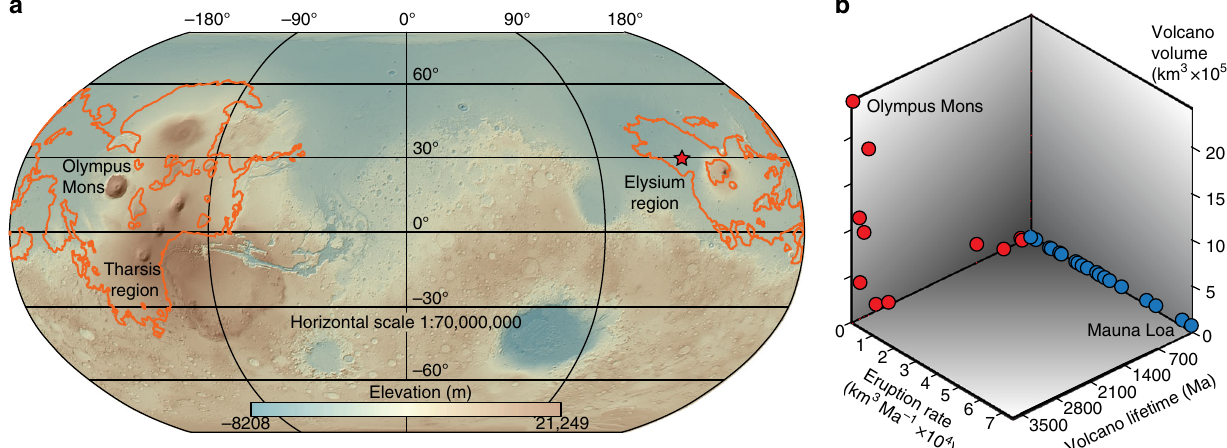
Fig. 1 Distribution and size of Martian volcanoes. a Amazonian volcanic products on Mars (digital elevation model and orange outlines 43 ) are located in the Tharsis and Elysium regions, with the largest volcano, the 600 km wide Olympus Mons, rising more than 21 km above the surrounding plains. The red star in the Elysium region marks the location of a potential source crater for the nakhlites 42 . b Relative characteristics of terrestrial and Martian plume volcanism. In comparison to terrestrial volcanoes ( blue ) those on Mars ( red ) have a greater volume and duration, but much lower eruption rates. Data